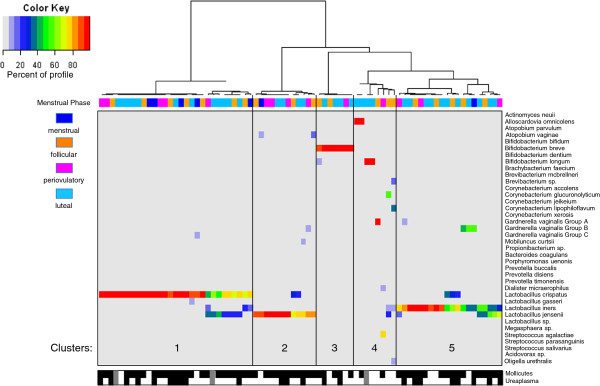
Hierarchic clustering of vaginal microbiome profiles by nearest-neighbor “species.” Only nearest-neighbor “species” comprising at least 1% of at least one sample are included. The color scale reflects the proportion of the total profile each “species” represented. Samples were divided into five clusters (indicated by numbers) based on average Jaccard similarities from 100 resampling runs. Colored blocks on the top indicate the menstrual phase of each sample. Mollicutes- and Ureaplasma-positive samples are indicated by black boxes below the heatmap (gray boxes indicate that the sample was not tested).